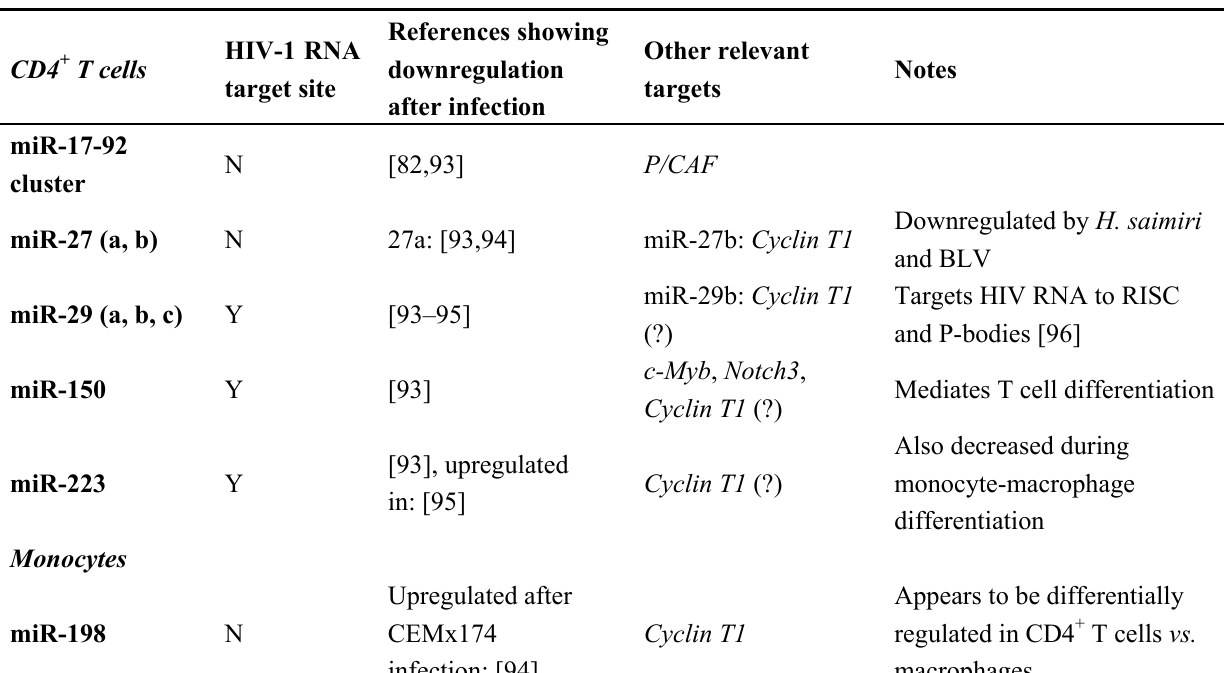
Table 1. MiRNAs down-regulated after CD4 + T cell activation or monocyte-macrophage differentiation. All miRNAs have also been shown to inhibit HIV-1 replication when overexpressed, and some have also been shown to undergo downregulation following in vitro HIV-1 infection. For other relevant targets, gene name followed by question mark indicates a possible indirect